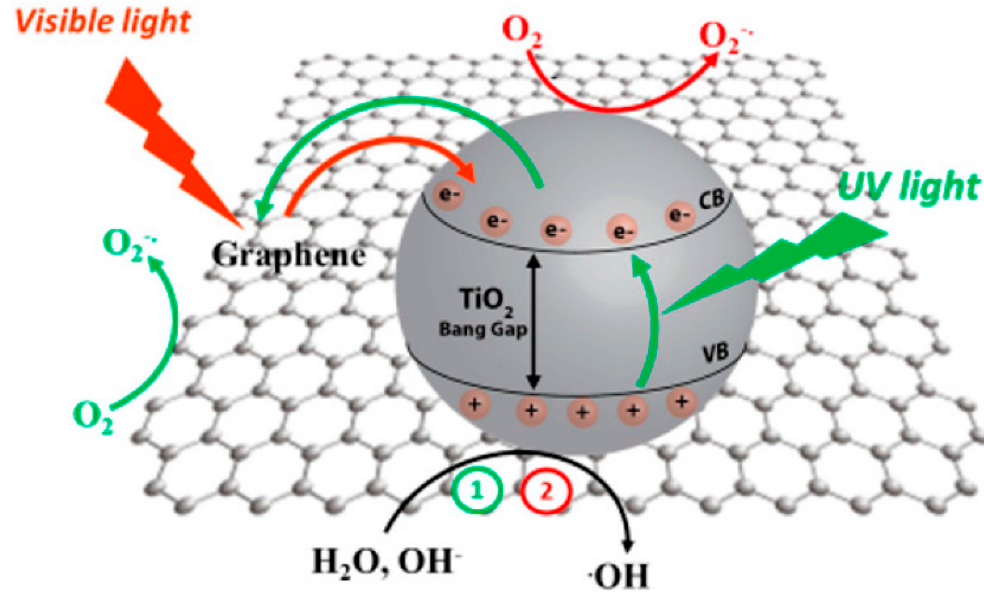
Figure 8. Mechanisms of UV and visible light activation of TiO 2 with graphene. (Reprinted from [110], Copyright (2017),